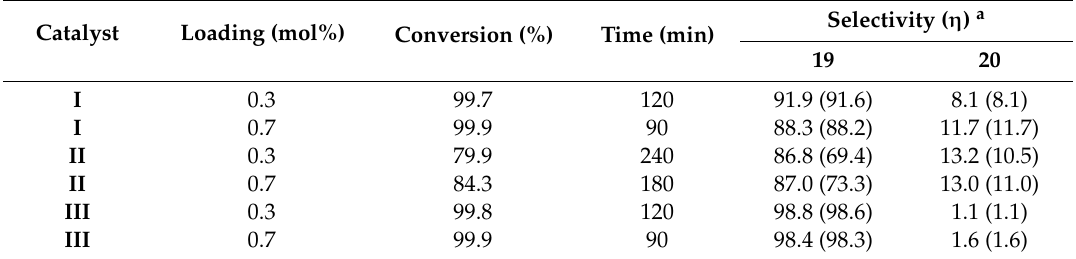
Table 1. Selectivity observed with Mn(III) catalysts I – III in the oxidation of 3MBF by H 2 O 2